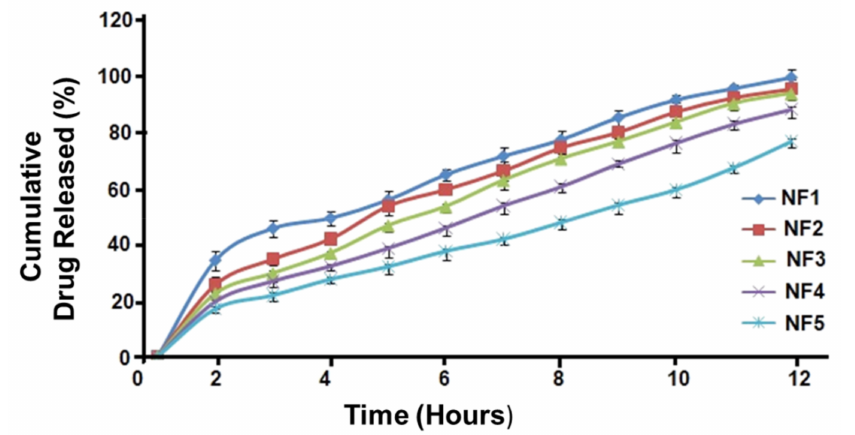
Figure 9. Drug release pattern for NOR nano